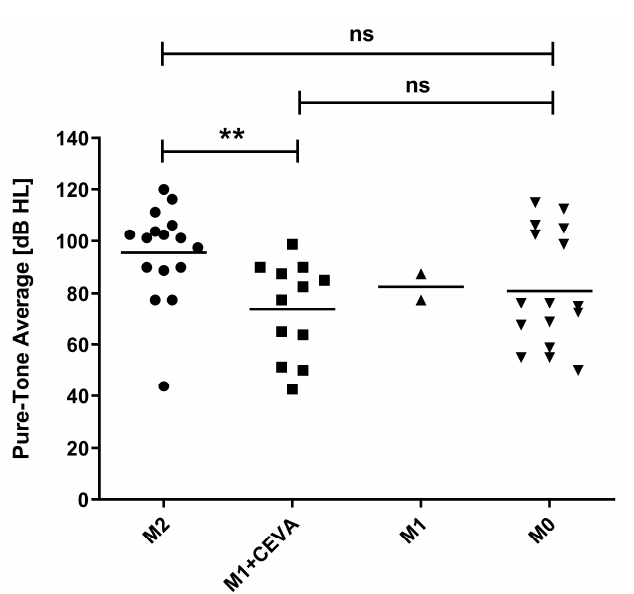
Figure 2. Average air-conduction thresholds for ears with EVA malformation. Each point represents one ear displayed according to SLC26A4 genotype. M2 indicates patients with two pathogenic variants of SLC26A4 ; M1 + CEVA indicates patients with one pathogenic variant of SLC26A4 in trans configuration with the CEVA haplotype; M1 indicates patients with only one SLC26A4 pathogenic variant; M0 indicates patients with no pathogenic variants in the SCL26A4 gene and the CEVA haplotype; ns, non-significant; **, p ≤ 0.01.